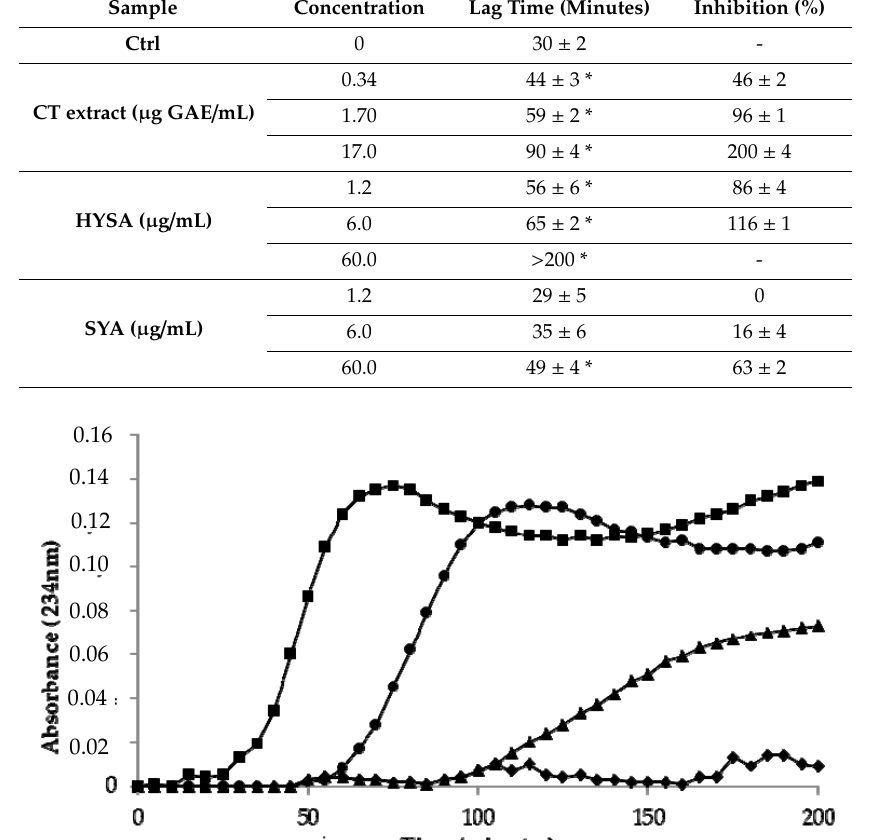
Table 3. Lag time and percentage of inhibition of conjugated dienes formation in Cu ++ —triggered LDL oxidation in the absence or in the presence of increasing concentrations of Carthamus Tinctorius (CT) extracts, hydroxy sa ffl or yellow A (HSYA) and sa ffl or yellow A (SYA). Phenolic concentrations of CT extract are expressed as µ g gallic acid equivalent (GAE) / mL. * p < 0.05 vs. LDL oxidized in the absence of polyphenols (control). Table 2. Comparison of values of antiradical activity evaluated by 2-diphenyl-1-picrylhydrazyl (DPPH) of Carthamus Tinctorius (CT) extracts, hydroxy safflor yellow A (HSYA) and safflor yellow A (SYA): IC 50 , EC 50 , and antiradical power (ARP). * p < 0.05 vs. CT extract; # p < 0.05 vs. HSYA.